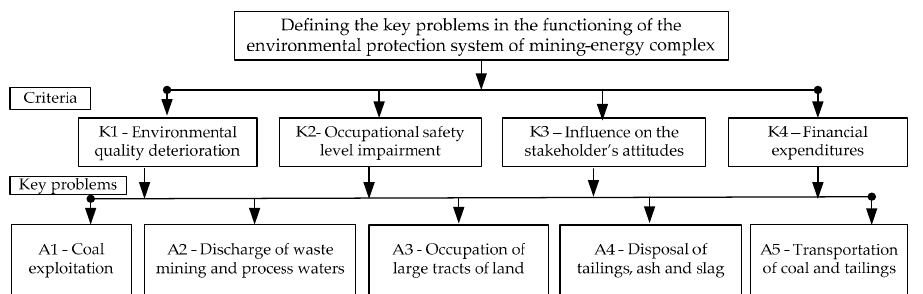
Figure 1. Defining key problems in operation of the environmental protection system in mining and energy complexes.